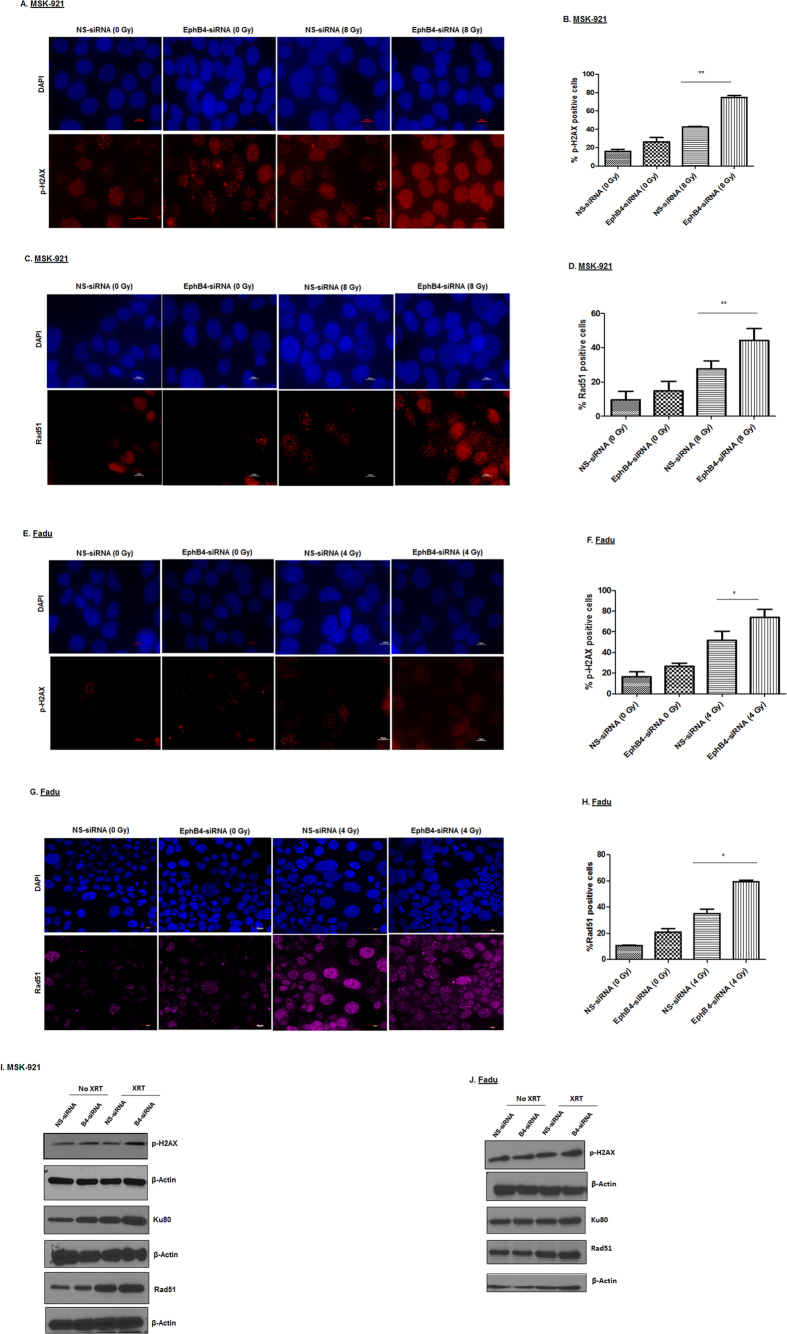
EphB4 downregulation combined with ionizing radiation enhances the DNA damage response in HNSCC cells.p-H2AX analysis shows a significant enhancement in the percentage of p-H2AX positive MSK-921 cells following EphB4 knockdown and ionizing radiation as demonstrated by immunofluorescence staining (A and B). In addition, an increase in Rad51-foci is also evident in MSK-921 cells (C and D). A similar trend was observed in Fadu cells in terms of p-H2AX (E and F) and Rad51 (G and H) expression. Data shown represent mean ± standard error from two to three independent experiments. *p < 0.05; **p < 0.005. Total magnification: 600–1000x. Western blot analyses demonstrate enhanced levels of p-H2AX, Ku80, and Rad51 indicative of the DNA damage response in the combination group compared to the other experimental groups in MSK-921 cells (I) and Fadu cells (J).